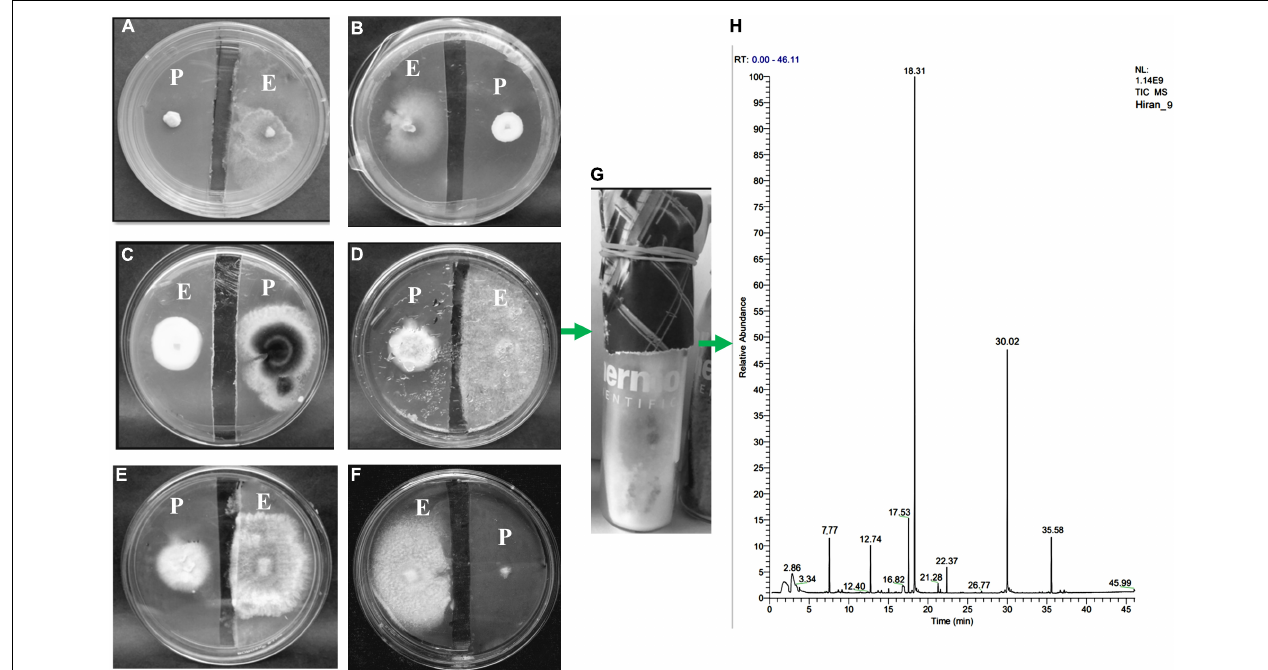
FIGURE 5 | An antifungal gas test performed by a split plate method (A–F) . The growth of pathogenic [ (A) Geotrichum candidum , (B) Botrytis cinerea , (C) Cercospora beticola , (D) Rhizoctonia solani , (E) Pythium ultimum , (F) Cercospora beticola ] fungi has been inhibited by the VOCs of endophytic fungi HelS1 (except in one case-C). (G) Represents how endophytic fungi are grown on GC-glass vials for VOC analysis. (H) GC-chromatogram of the VOCs produced by the endophytic HelS1.